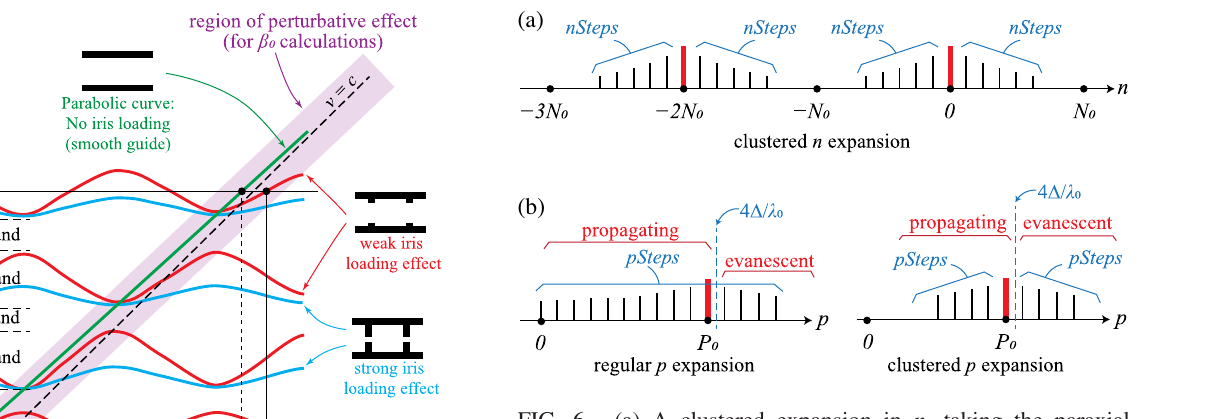
FIG. 6. (a) A clustered expansion in n , taking the paraxial dominant harmonic (in red) to be the basic harmonic ( β n ¼ β 0 ) at n ¼ 0 , which corresponds to approximately N 0 wavelengths per structure period, where N 0 is the nearest integer to b= λ 0 . This means that the image of the dominant harmonic is at the index n ¼ − 2 N 0 (in red). Note that the expansion is equivalent to P lar versus clustered expansion in p , where the dominant mode in region 2 (excited by the paraxial incidence in region 1) happens at index p ¼ P 0 , where P 0 is the floor integer nearest to 2 Δ = ð λ 0 = 2 Þ from below (i.e., number of half wavelengths in the width 2 Δ ). P pSteps The regular expansion here is p ¼ 0 , and the clustered P P 0 þ pSteps pSteps expansion is p ¼ P 0 − pSteps , where we choose